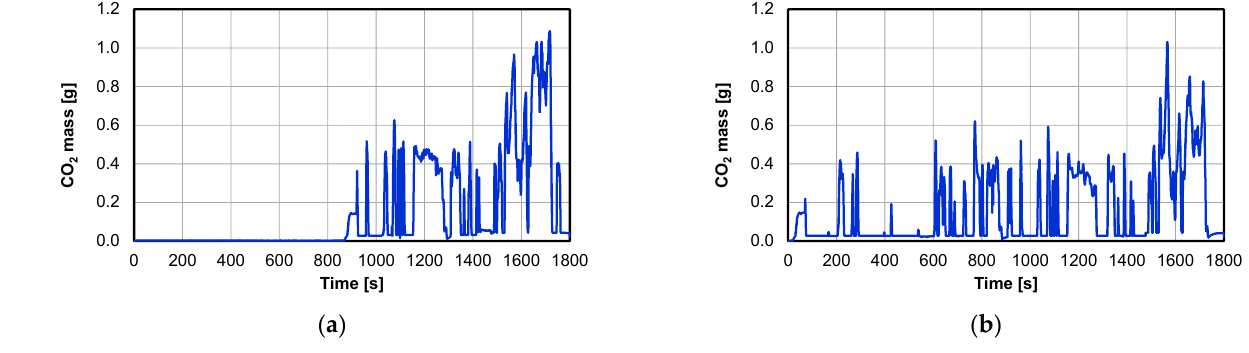
Figure 17. The CO 2 mass versus time for: ( a ) plug-in; ( b ) HEV.